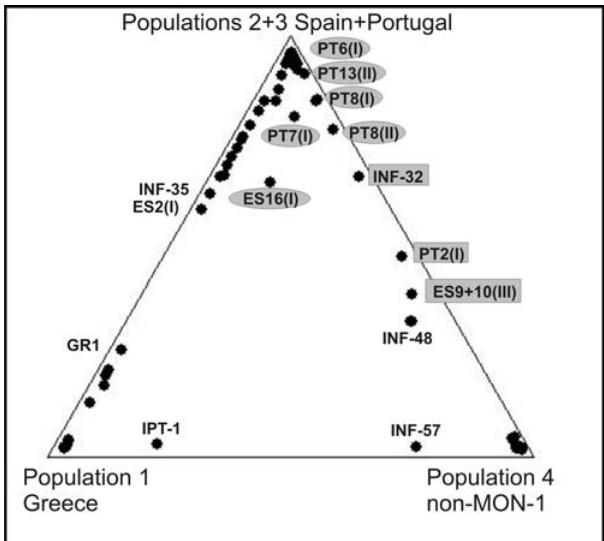
Figure 3. Traces of gene flow between the L. infantum populations shown by a triangle plot. The triangle plot of proportion of ancestry from three sources designated population 1 (Greece), population 4 (non-MON-1) and combined populations 2 and 3 (Majorca/Ibiza and mainland Spain and Portugal) as inferred from K =4 in STRUCTURE analysis shows traces of gene flow between the populations. Each data point corresponds to a single strain whose proportion of ancestry from each of the three sourcesis represented by its proximity to the corresponding corner of the triangle. Strains of mixed MON-1/non-MON-1 ancestry and mosaic genotypes are labeled in grey (rectangles-most of the loci are heterozygous; ellipses-few loci are heterozygous). ES16(I) is homozygous for all loci, however representing a combination of alleles typical for different populations. non-MON-1 population. The values of H e differed between MON-1 (0.197–0.348) and non-MON-1 (0.621). The highest degree of heterozygosity was observed for the non-MON-1 population, the lowest in population 3 (MON-1 Portugal + Spain